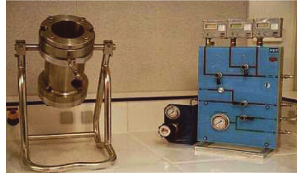
Fig. 15. Permeability test.